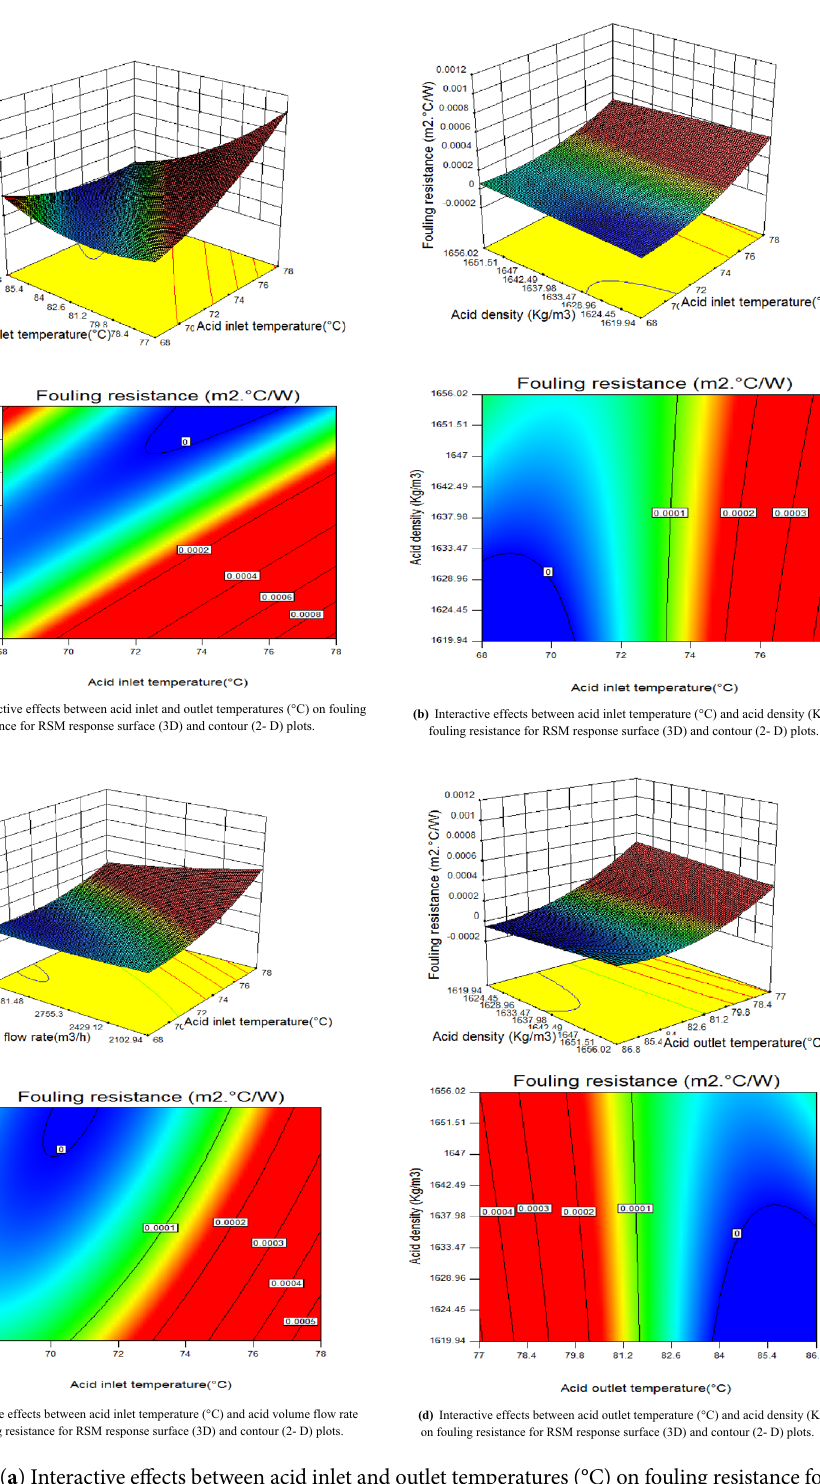
Figure 3. ( a ) Interactive effects between acid inlet and outlet temperatures (°C) on fouling resistance for RSM response surface (3D) and contour (2-D) plots. ( b ) Interactive effects between acid inlet temperature (°C) and acid density (Kg/m 3 ) on fouling resistance for RSM response surface (3D) and contour (2-D) plots. ( c ) Interactive effects between acid inlet temperature (°C) and acid volume flow rate (m 3 /h) on fouling resistance for RSM response surface (3D) and contour (2-D) plots. ( d ) Interactive effects between acid outlet temperature (°C) and acid density (Kg/m 3 ) on fouling resistance for RSM response surface (3D) and contour (2-D) plots. ( e ) Interactive effects between acid outlet temperature (°C) and acid volume flow (m 3 /h) on fouling resistance for RSM response surface (3D) and contour (2-D) plots. ( f ) Interactive effects between acid density (Kg/ m 3 ) and acid volume flow (m 3 /h) on fouling resistance for RSM response surface (3D) and contour (2-D)